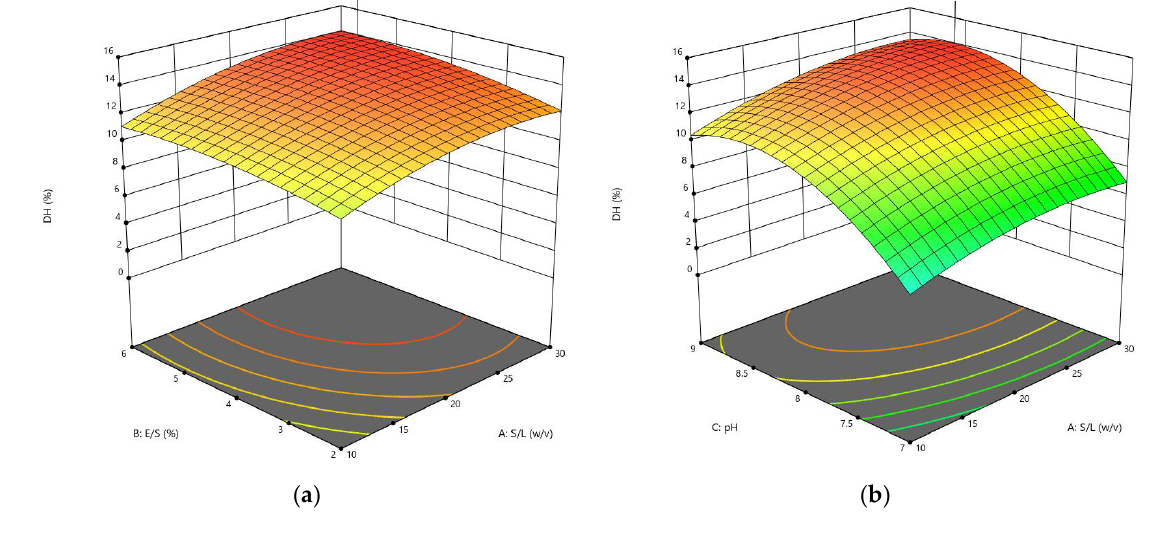
Figure 1. Three-dimensional (3D) response surface plots showing the influence of variable param- eters on DH response using alcalase: ( a ) E/S ratio vs. S/L ratio, ( b ) pH vs. S/L ratio, ( c ) temperature